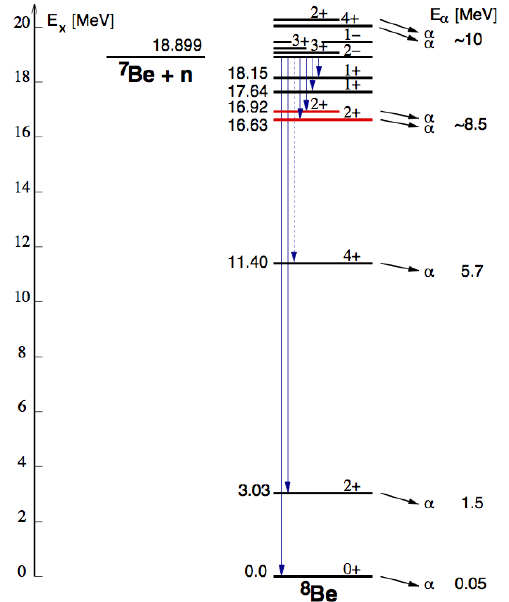
Figure 2. Schematic level and decay scheme of 8 Be transitions. The levels accessible experimentally in the n_TOF measurement are indicated in red. Reprinted figure with permission from: Barbagallo et al. (n_TOF Collaboration), Phys. Rev. Lett. 117, 152701—2016. Copyright (2016) by the American Physical